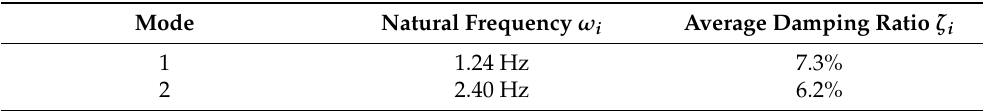
Table 1. Wet natural frequencies and damping ratios for the first two vibration modes, obtained using the modal analysis and experimental